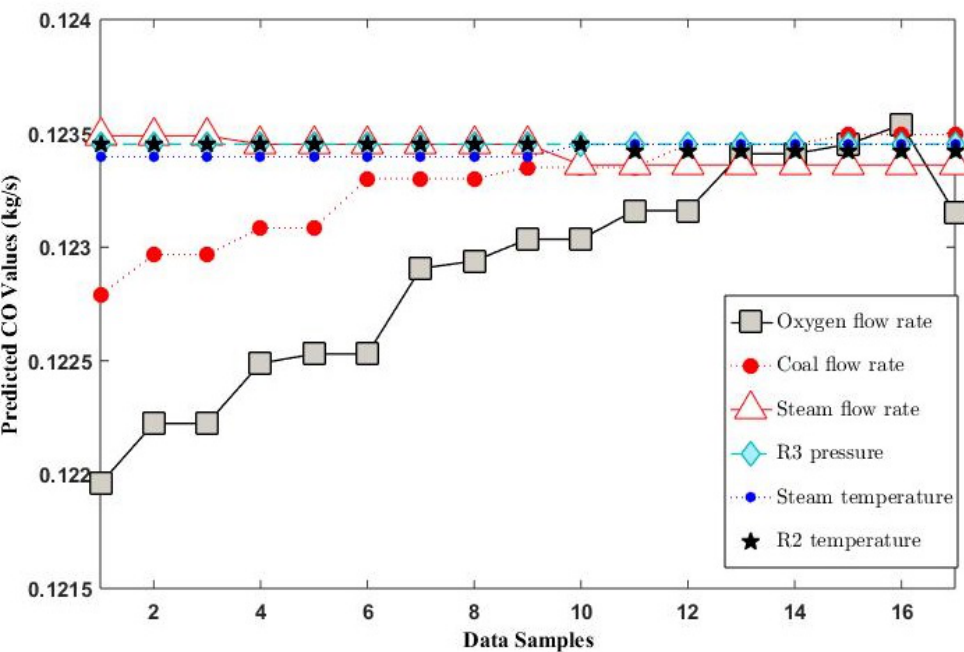
Figure 7. Sensitivity analysis of oxygen flow rate, coal flow rate, steam flow rate, R3 pressure, steam temperature, and R2 temperature through the ensemble